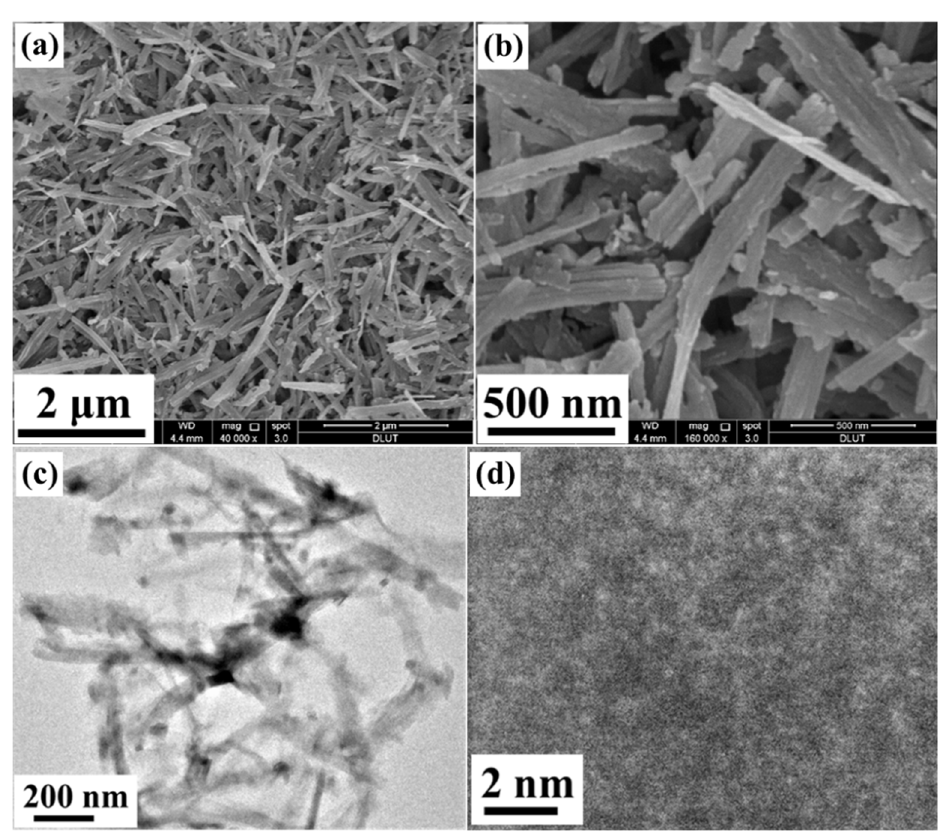
Figure 3. ( a , b ) FE-SEM images of PCoSi; ( c ) TEM image of PCoSi; ( d ) HRTEM image of PCoSi.